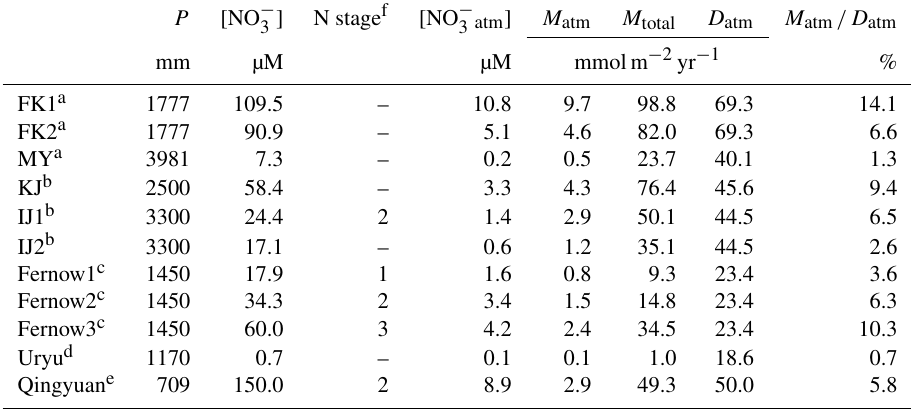
Table 3. The annual amount of precipitation ( P ), the average concentration of stream nitrate ([NO − ]), the nitrogen saturation stage, the 3 in streams ([NO − ]), the annual export flux of NO − per unit area of catchment ( M total ), average concentration of unprocessed NO − 3 atm 3 atm 3 the annual export flux of NO − per unit area of catchment ( M atm ), the deposition flux of NO − per unit area of catchment ( D atm ), and 3 atm 3 atm the M atm /D atm ratio in the FK1, FK2, and MY, along with those in the catchments studied in past studies using (cid:49) 17 O of nitrate as a tracer.